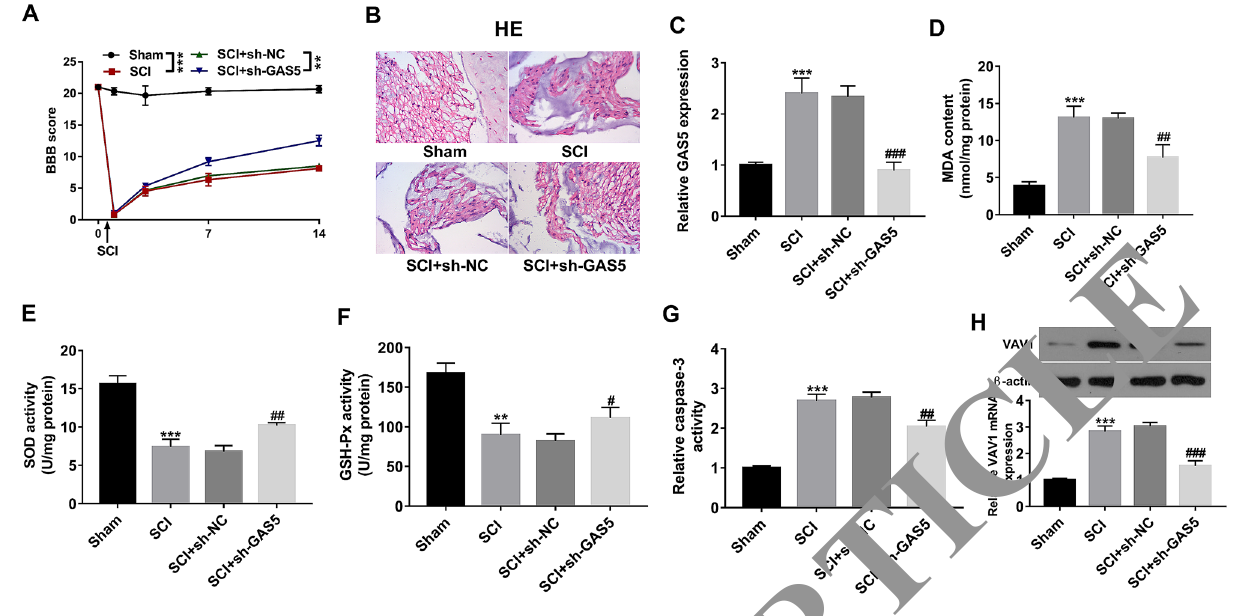
Figure 1. GAS5 knockdown alleviated SCI by reducing oxidative stress and inhibiting cell apoptosis in rat models. ( A ) BBB scores were recorded on day 0, 1, 3, 7, 14 post SCI. ( B ) HE staining analysis for spinal cord tissues was performed on day 14 after contusion injury. ( C – H ) GAS5 level, MDA content, SOD/GSH-Px/ caspase-3 activity and VAV1 expression level in spinal cord tissues were measured on day 14 after contusion injury. * P < 0.05, ** P < 0.01, *** P < 0.001, # P < 0.05, ## P < 0.01, ### P <